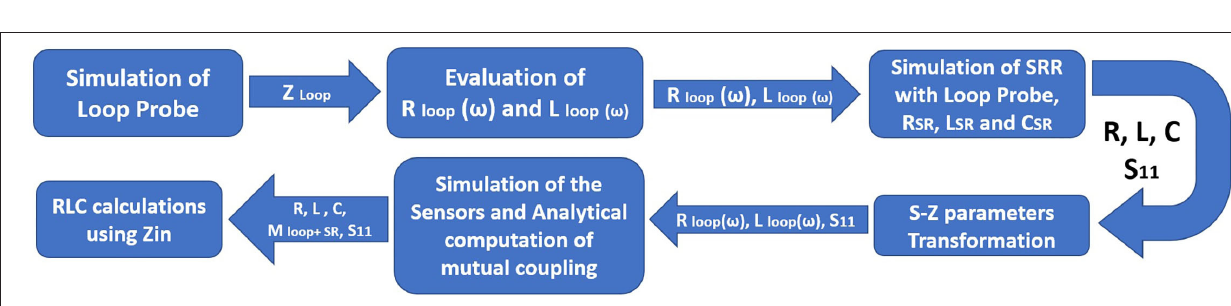
FIGURE 8 | Flowchart of the retrieving RLC parameters for the proposed